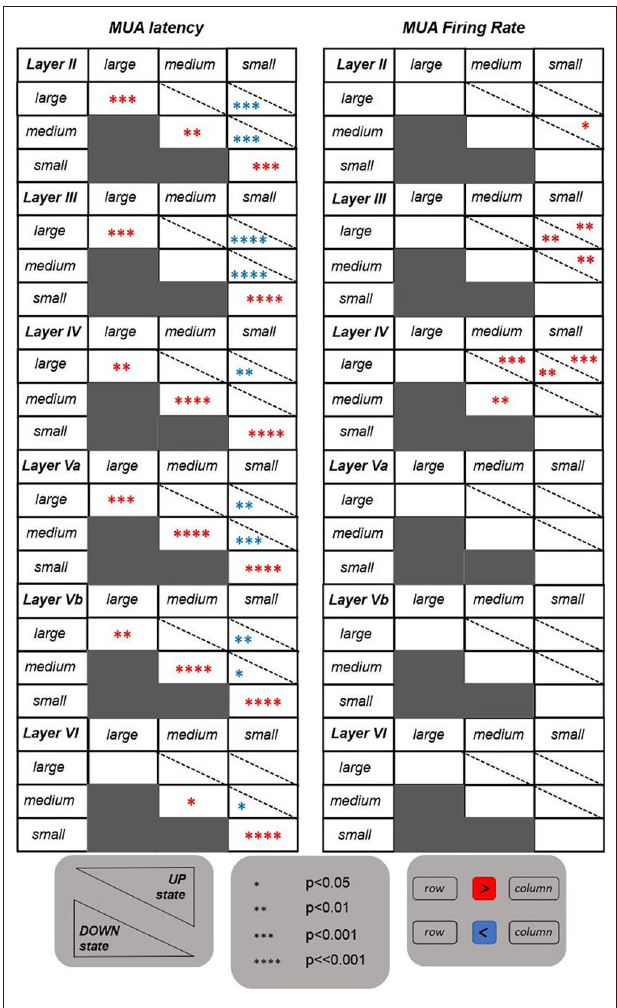
FIGURE 3 | Tables reporting the statistical results for the features extracted from the evoked MUAs. Same as in Figure 2 , but referring to the two features extracted from